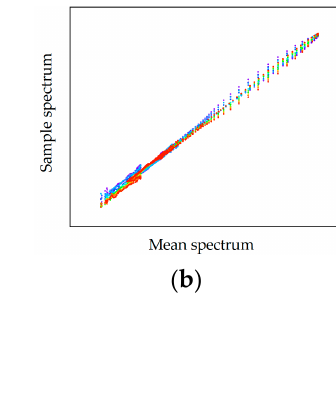
Figure 9. Raman spectral data for precipitation ( a , b ) and dissolution ( c , d ). Preprocessed spectral data are presented in ( a , c ). ( b , d ) show the PLS regression results of the prediction of the investigated CQAs. Different colors represent the spectral data for different samples and are sorted from red to blue. Sample names are equal to Figure 6. Spectral data ( c , d ) have been previously published [6].